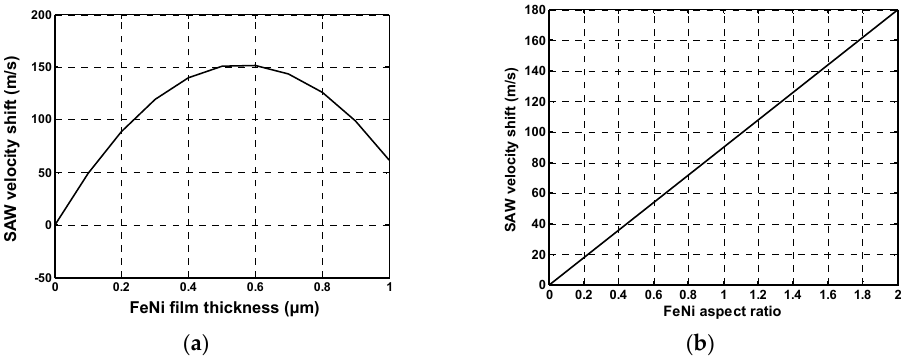
Figure 4. The calculated relationship among the sensor response and the FeNi film thickness ( a ), and the aspect ratio ( b ), where the electromagnetic field intensity is set to 200 Oe.